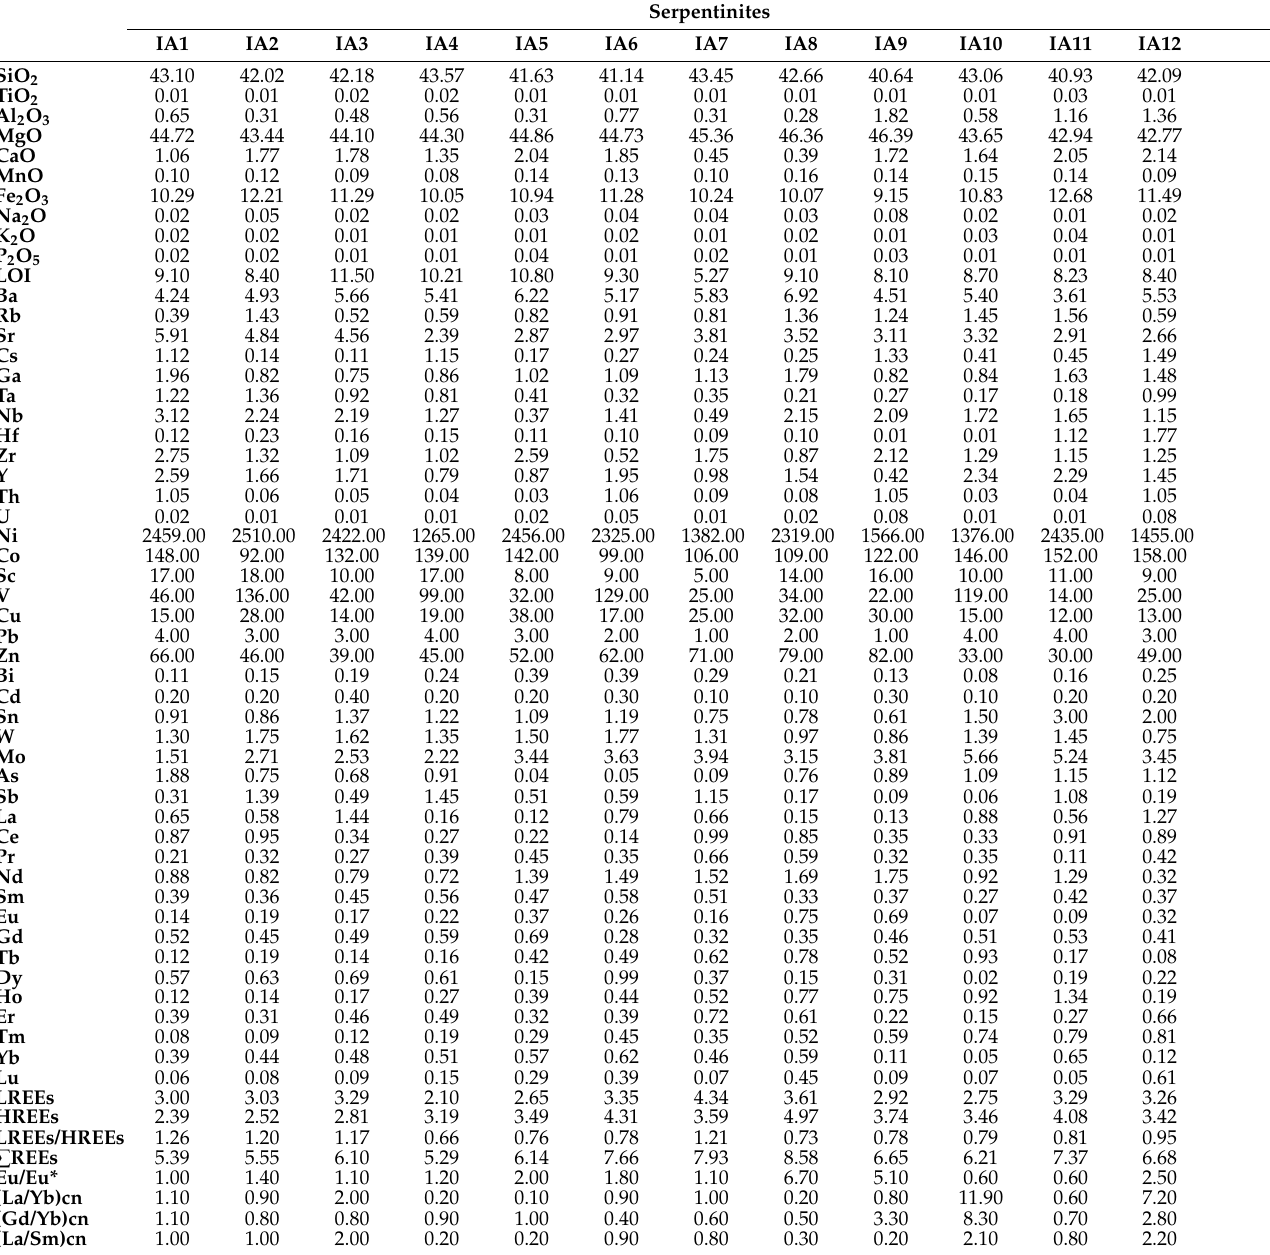
Table 2. Abundances of major (wt.%), trace, and rare earth elements (ppm) in ultramafic